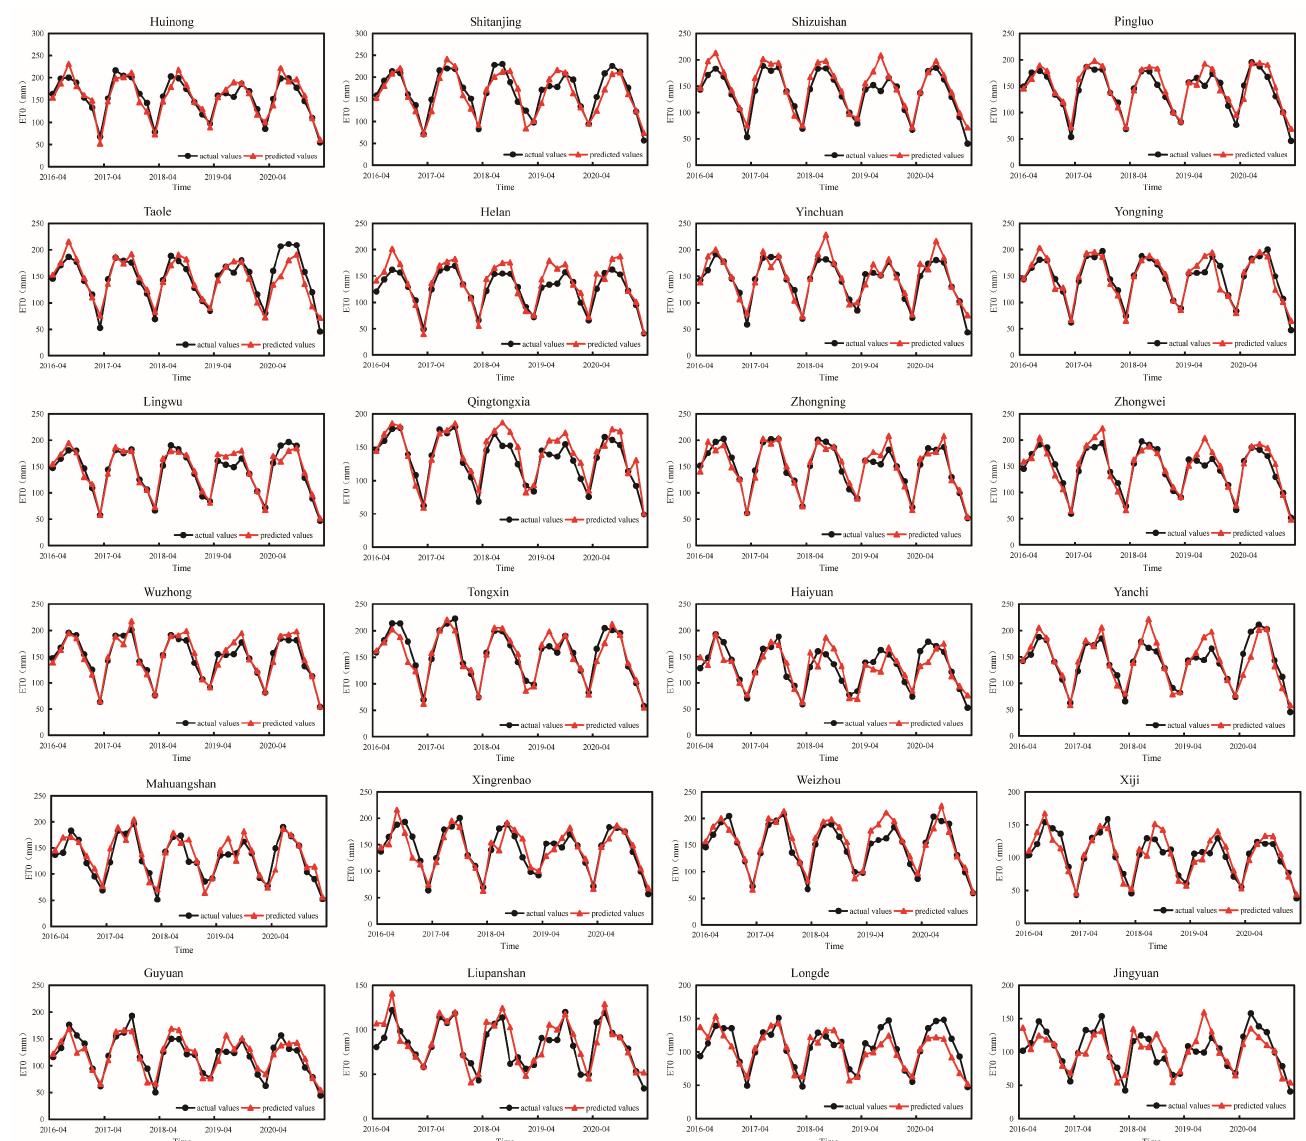
Figure 11. Monthly extrapolated predicted values of potential evaporation in various regions of Ningxia .